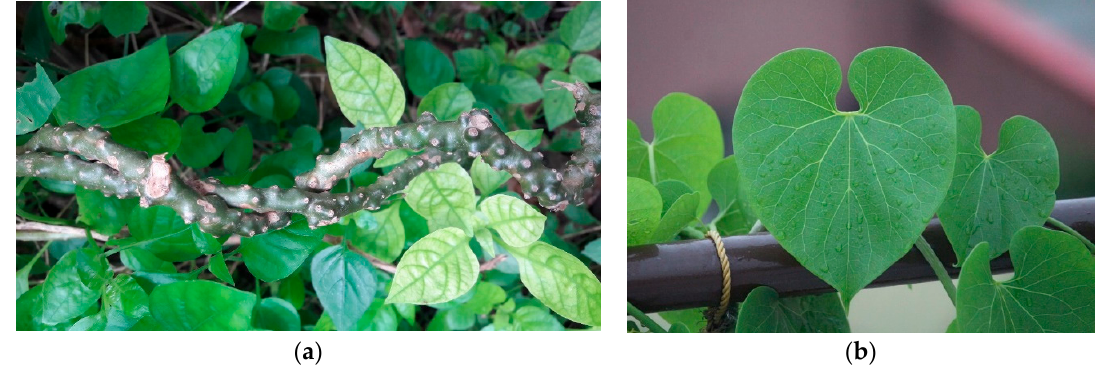
Figure 10. Tinospora crispa : ( a ) whole plant and ( b ) leaves.